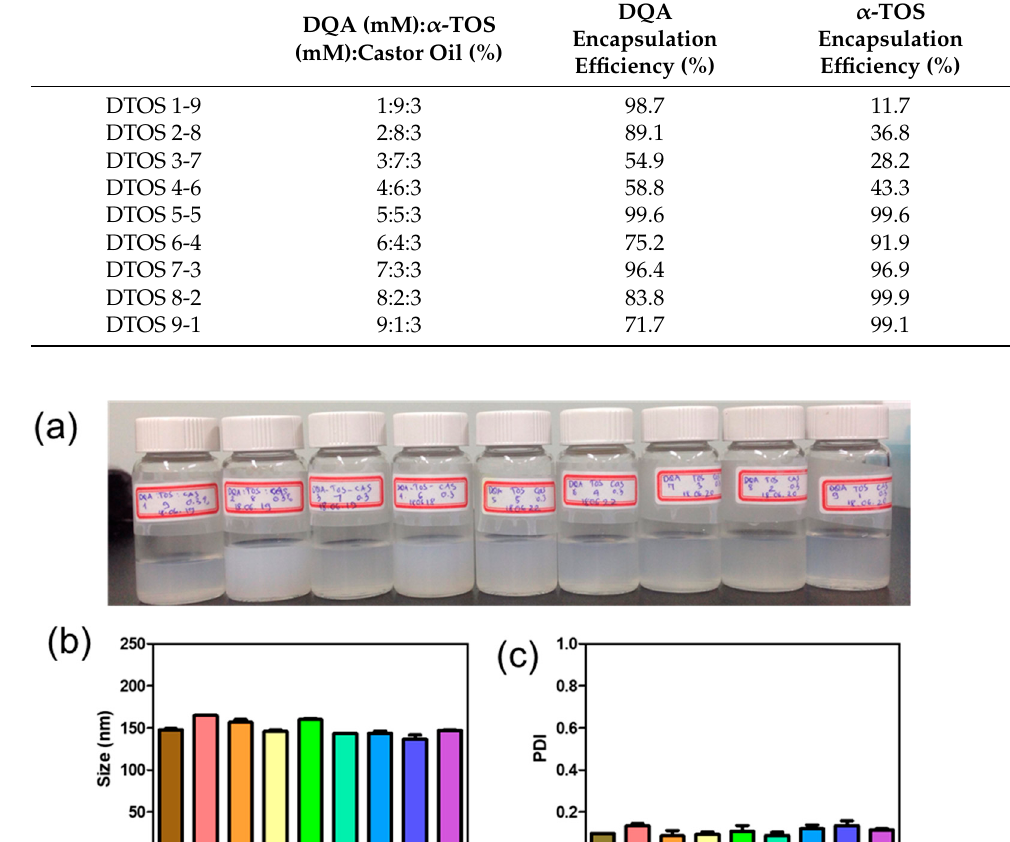
Table 1. Encapsulation efficiency of DQA and α -TOS emulsions.